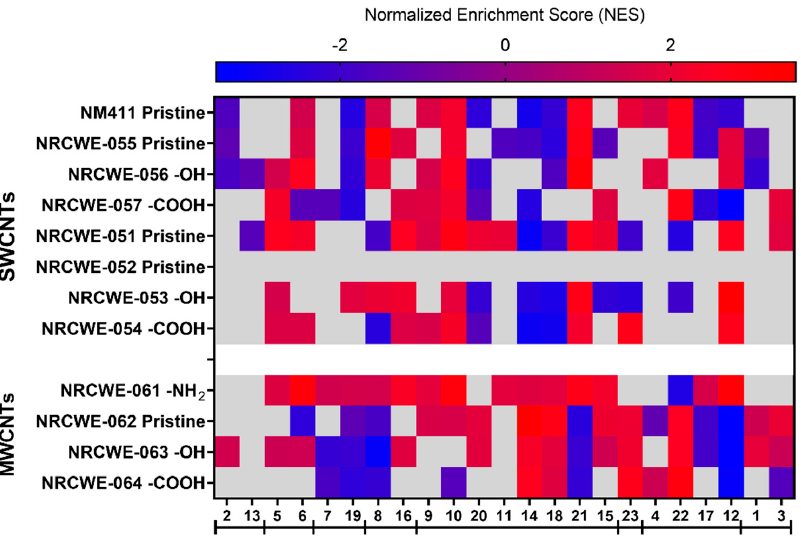
Figure 8. Modules over-represented or under-represented after 1 day of exposure to CNTs at the 6 µ g/mouse dose. Red: positive NES values represent gene set enrichment at the top of the ranked list. Blue: negative values represent gene set enrichment at the bottom of the ranked list. Enriched sets were considered significant if their NES had an adjusted p -value ≤ 0.05 (gray represents modules that were not significant). The bars group the modules with similar biological functions based on the IPA analysis.